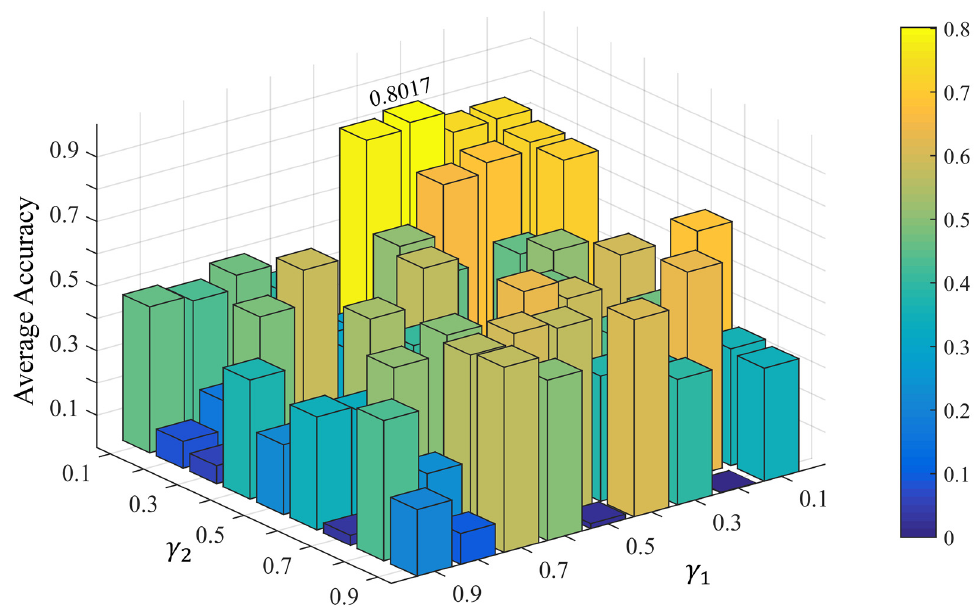
Figure 17. SEIARN parameter traversal result graph.